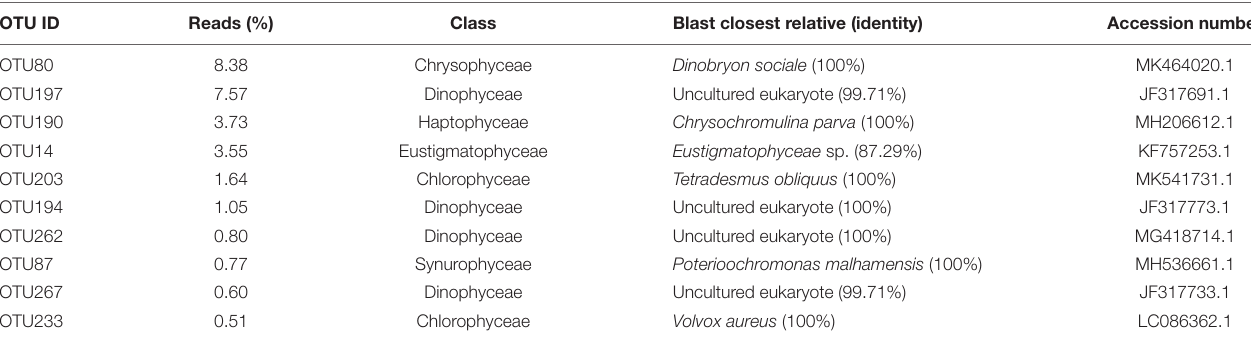
FIGURE 5 | The taxonomic composition at class level of PPEs from the sorted samples in Lake Fuxian. TABLE 4 | Taxa of the 10 most abundant PPEs OTUs in Lake Fuxian,